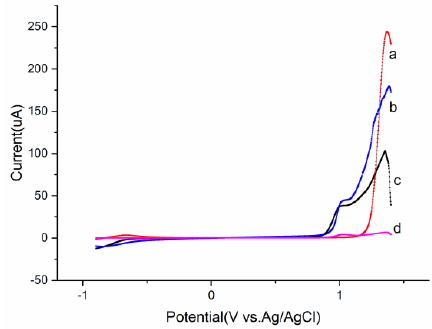
Figure 2. The LSV of 0.01 M EDOT in different electrolyte solutions: 0.01 M EDOT and 0.1 M TBAP in acetonitrile (a) 0.01 M EDOT in water (b) 0.01 M EDOT, 0.1 M LiClO 4 and 5 mM C 12 H 25 SO 4 Na in water (c) and 0.01 M EDOT, 0.1 M LiClO 4 and 5 mM C 12 H 25 SO 3 Na in water (d).